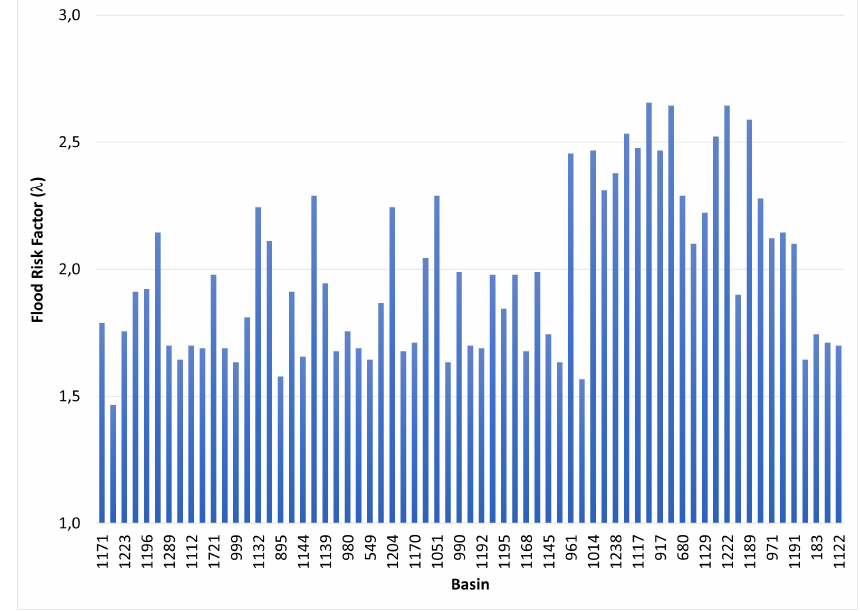
Figure 4. FRF results by